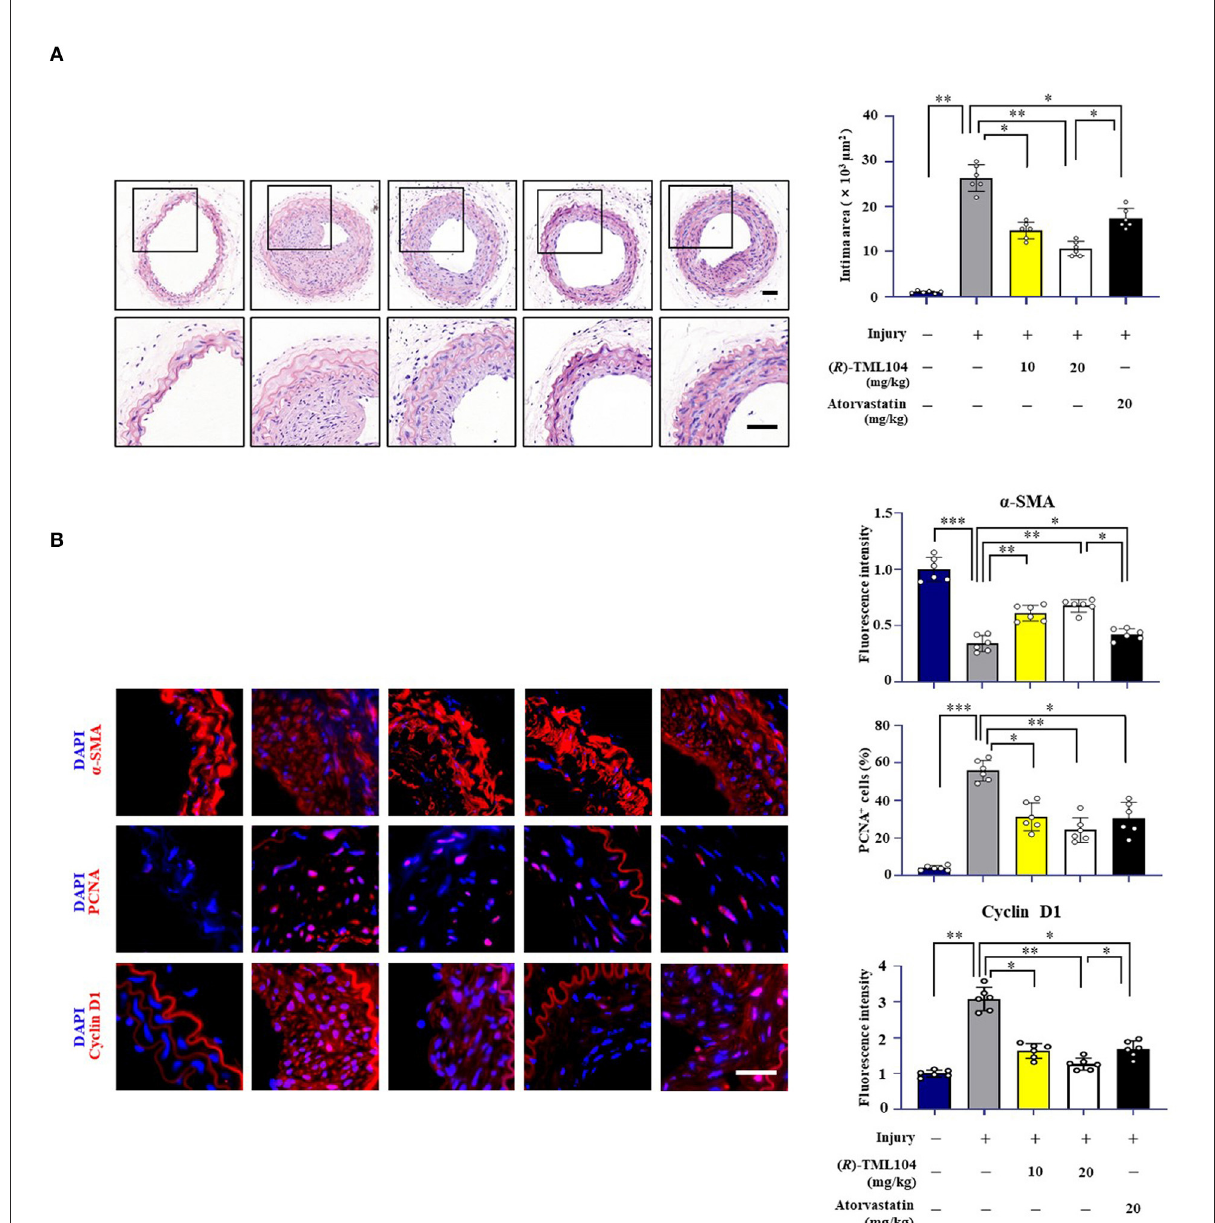
FIGURE1 ( R )-TML104 mitigates injury-induced neointima formation in vivo . (A) Hematoxylin and Eosin (H&E) staining of sections at 28 days after injury (Scale bar: 50 µ m). (B) Immunofluorescence staining of α -SMA, PCNA, and cyclin D1 on sections of carotid arteries from mice. Scale bar: 50 µ m, Data shown are means ± S.D ( n = 6). * p < 0.05, ** p < 0.01, *** p <